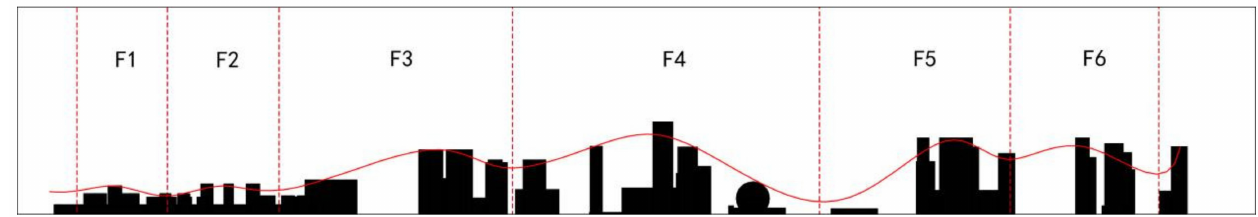
Figure 16. Hangzhou Qianjiang New City skyline’s